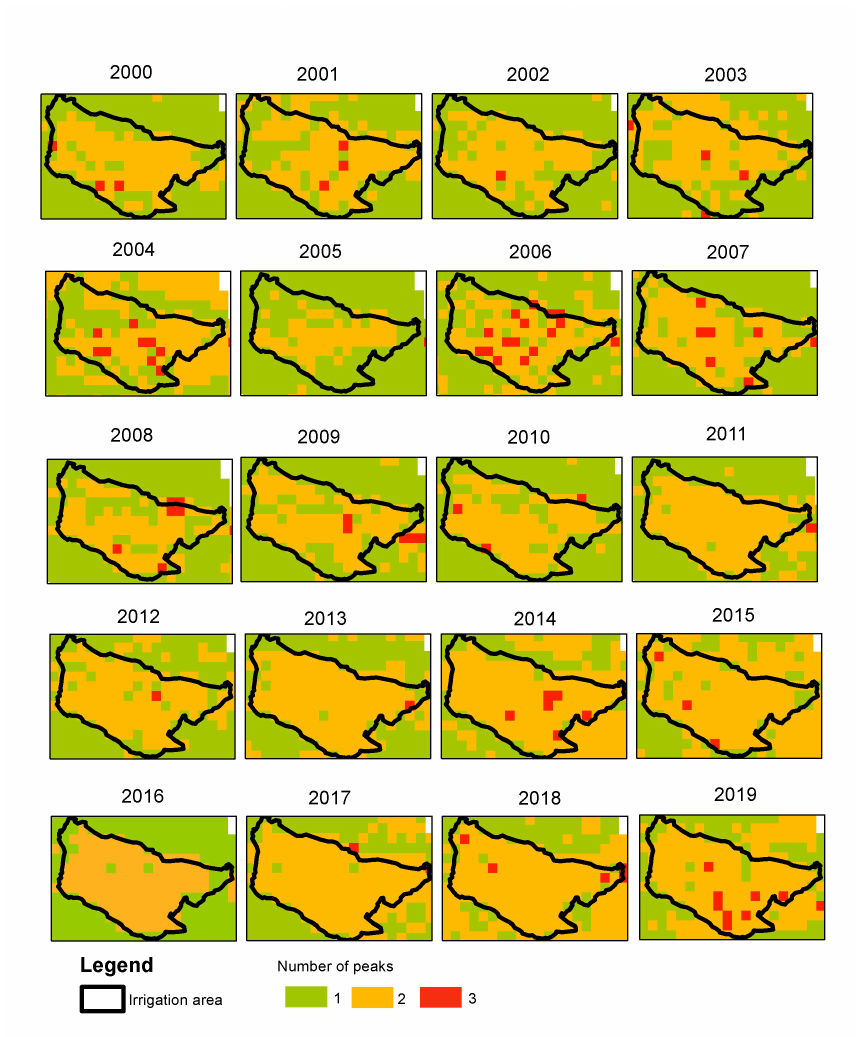
Figure 9. Spatio-temporal distribution of the number of peaks per year in Santo Domingo,